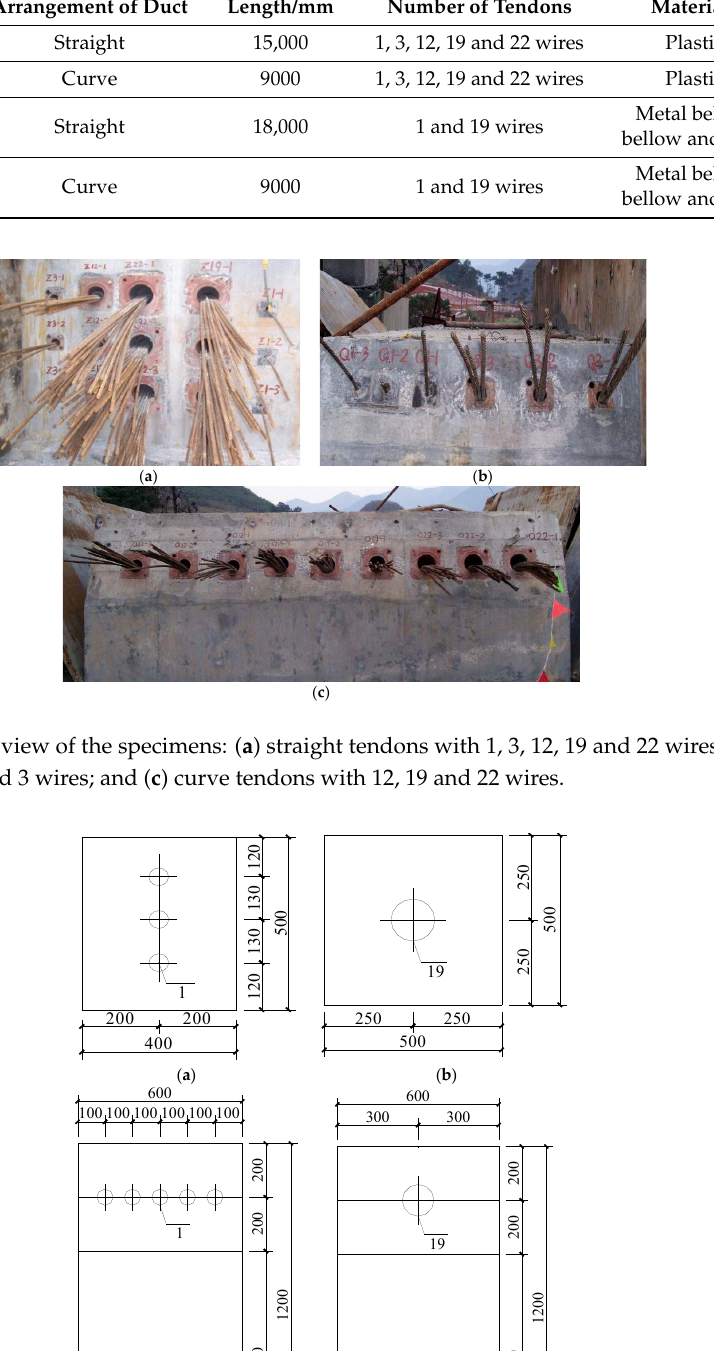
Figure 5. Arrangement for the duct based on the project of Wujiang Bridge: ( a ) straight tendons with 1 wire; ( b ) curve tendons with 19 wires; ( c ) curve tendons with 1 wire; and ( d ) curve tendons with 19 wires (unit: mm).